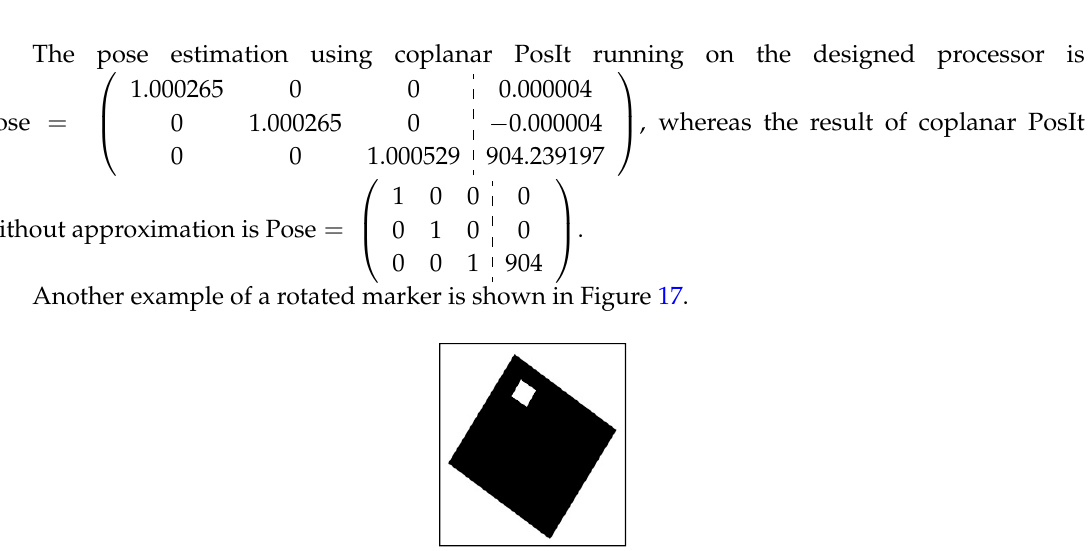
Figure 17. Illustration of an input frame with a rotated marker.